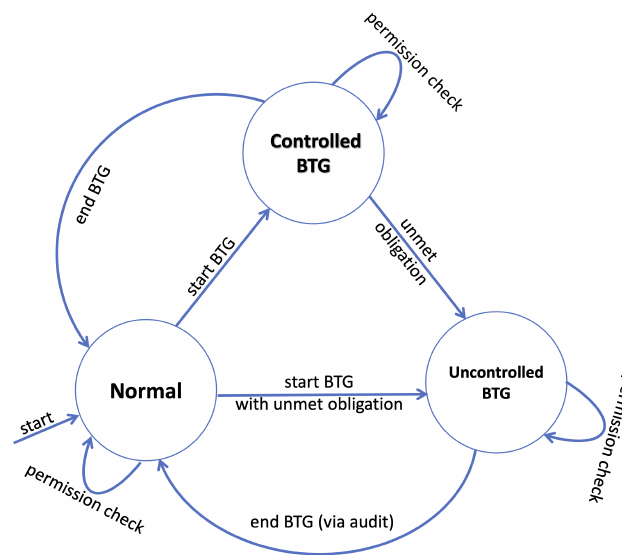
Figure 2. BTG state machine showing the normal state and two emergency (BTG) states, along with transition criteria. The system starts in “Normal” and moves into “Controlled BTG” when BTG is activated, as long all BTG obligations are met (otherwise the system transitions to “Uncontrolled BTG”). Normal state can be restored via automated or semi-automated audit from Controlled BTG, or via manual audit from Uncontrolled